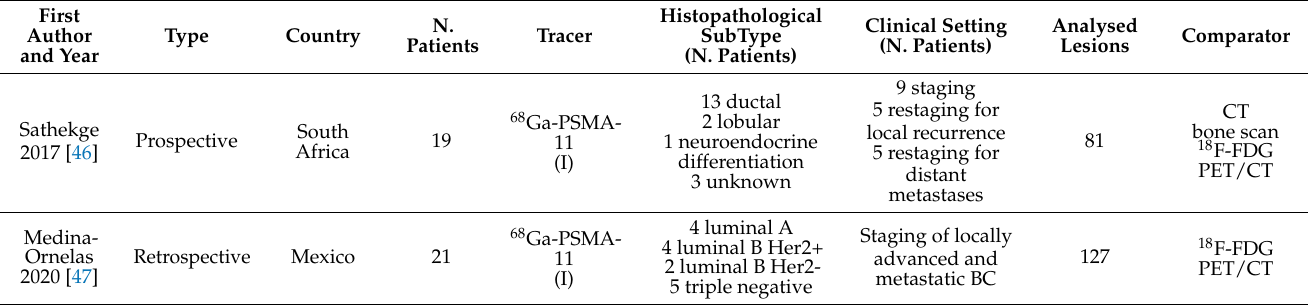
Table 4. Characteristics of the included studies which employed PSMA radioligands in breast